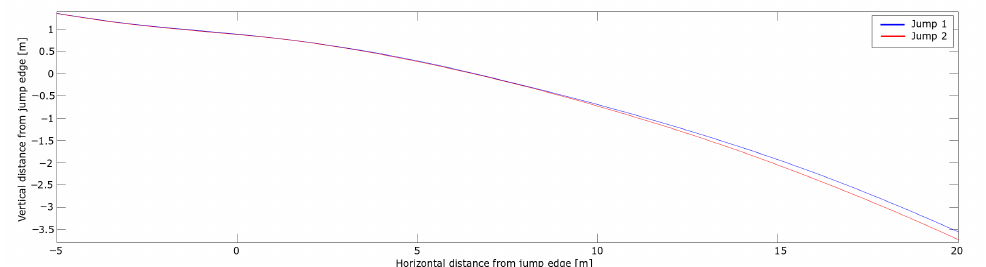
Figure 9. CoM trajectory during the take-off and early flight phase for the two jumps in the case analysis. The horizontal and vertical distance from the in-run edge are shown on the x-axis and y-axis,